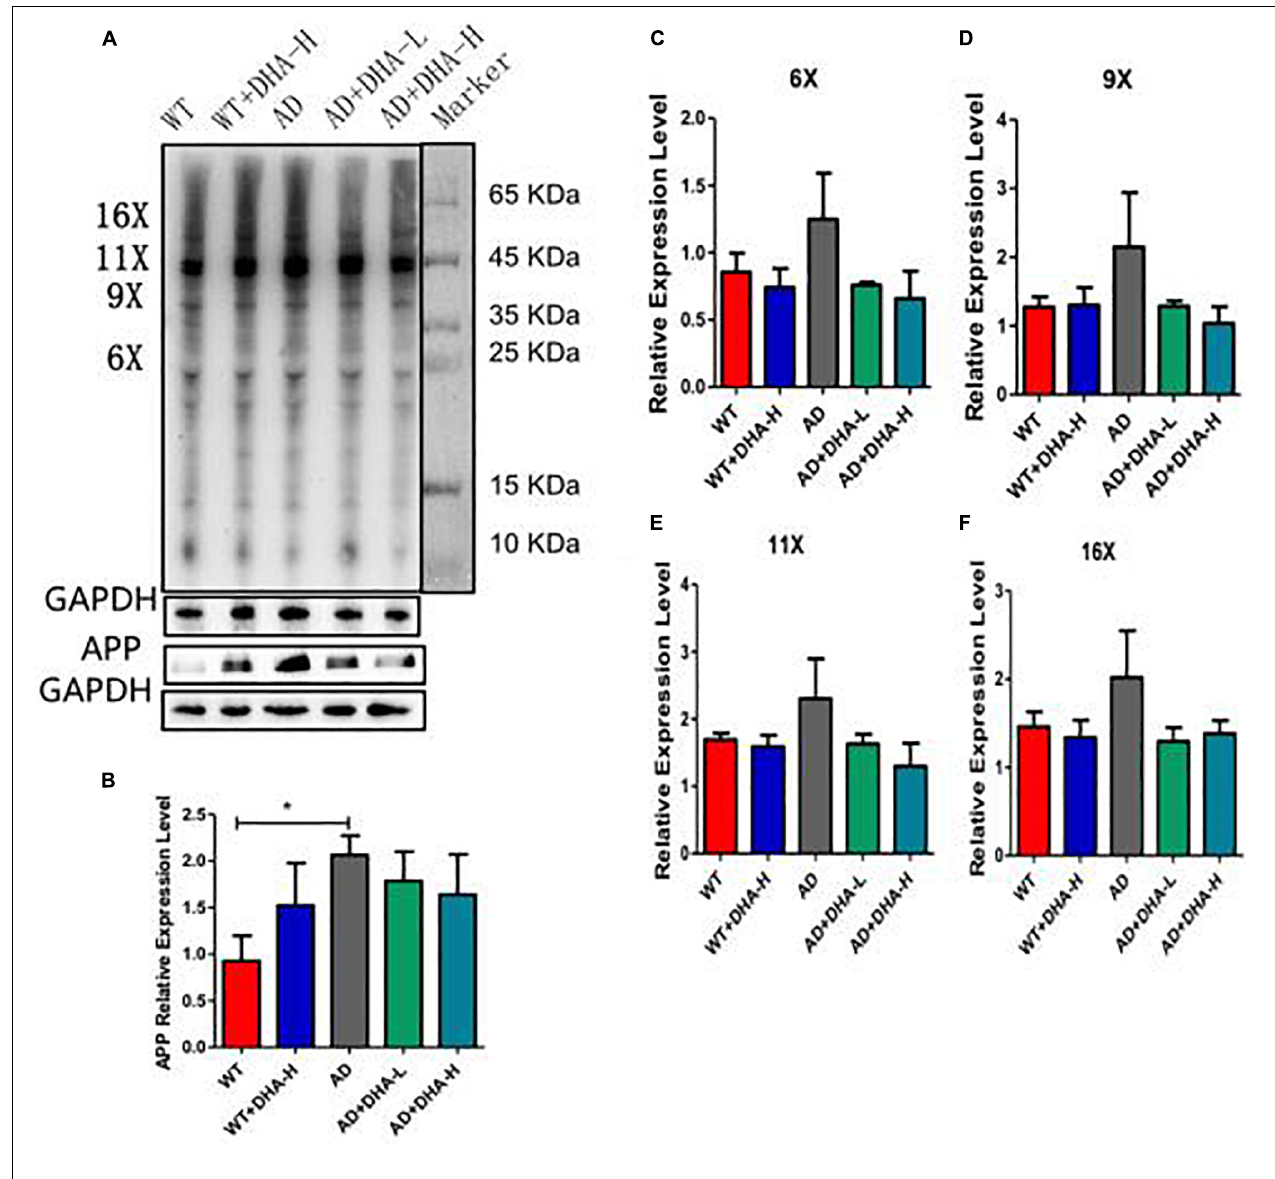
FIGURE 3 | Detection of A β protein levels in mouse cortex tissue ( n = 4). (A) Western blot detection of the expression levels of A β oligomers and APP in hippocampus; (B) Quantitative analysis of gray value of APP protein expression level; (C) Quantitative analysis of gray value of 6-fold oligomer of A β protein; (D) A β protein 9 Gray value quantitative analysis of fold oligomers; (E) Gray value quantitative analysis of A β protein 11-fold oligomers; (F) Gray value quantitative analysis of A β protein 16-fold oligomers (* p <